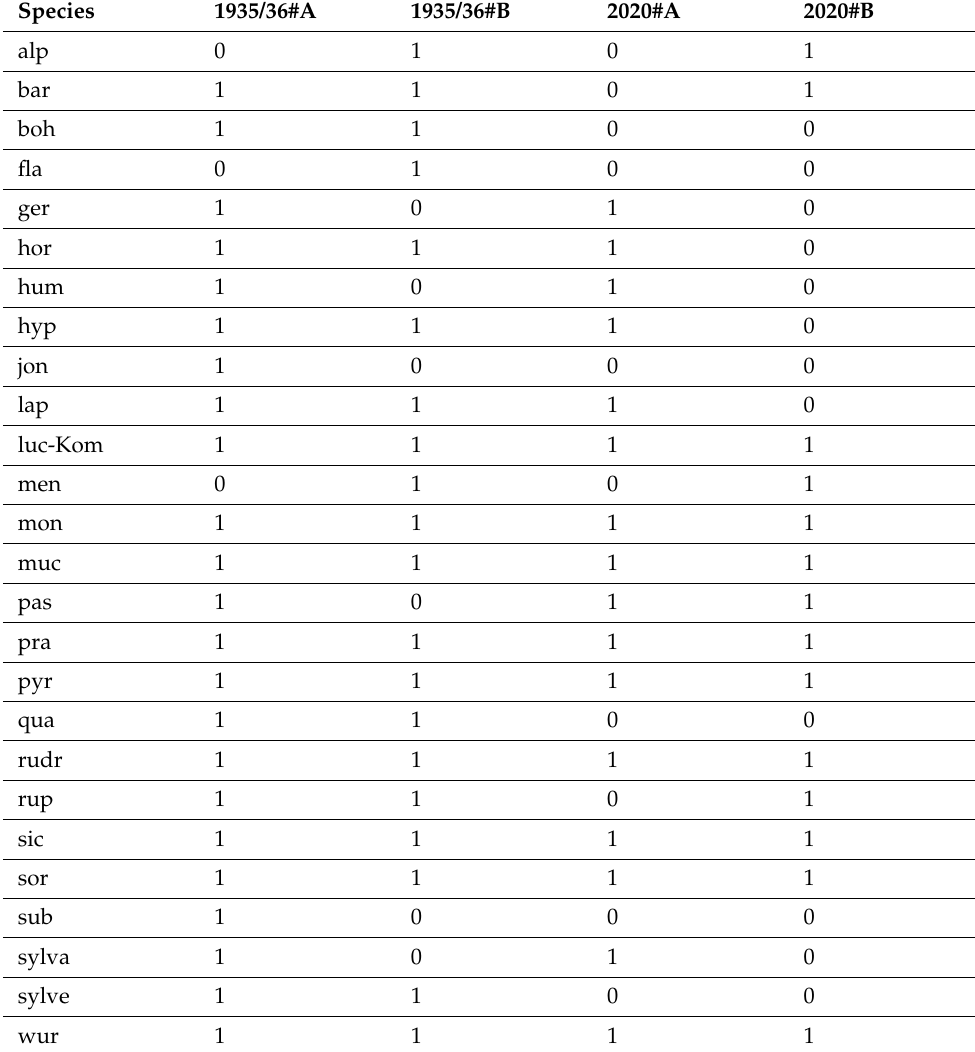
Table A3. Distribution of bumblebee species over cluster groups (binary; presence = 1, absence = 0). The first character string of the column name denotes the sampling year. The second character string denotes the group (A = 1550 masl, B = 2150 masl). Species abbreviations are as follows: